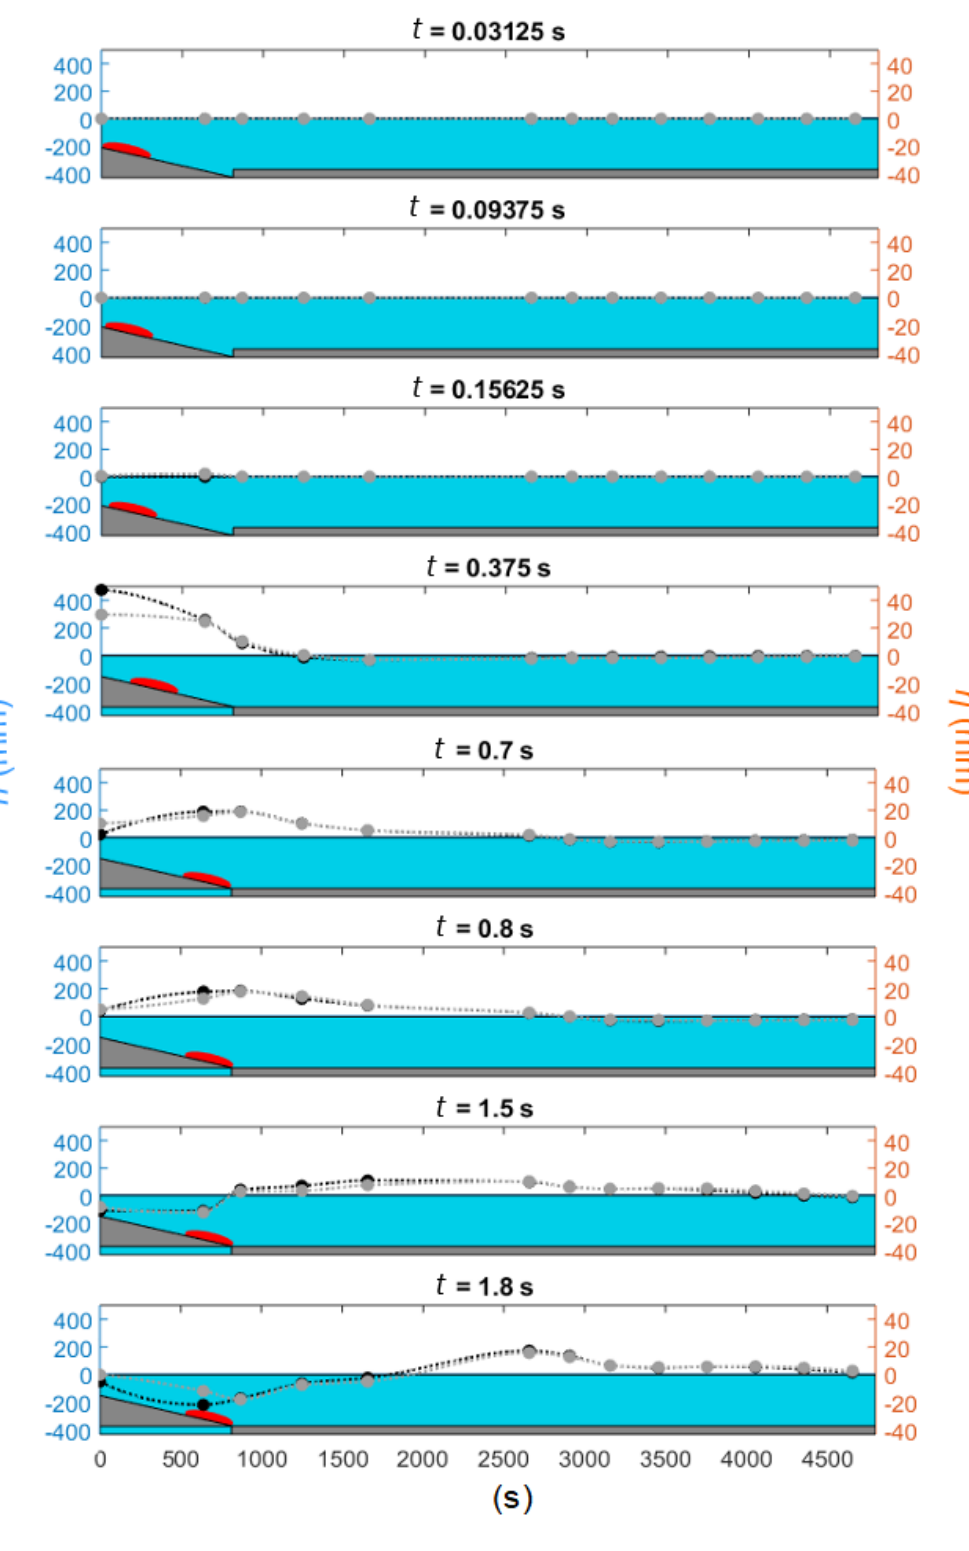
Figure 15. Stacked plots showing the setup with the surface elevation time histories for uplift-only tests (grey) and uplift followed by landslide ML3 for a 60 mm uplift and 370 mm water depth. The displacement time histories for the fault rupture are shown as the plate lifts up between t = 0.03125 s and t = 0.375